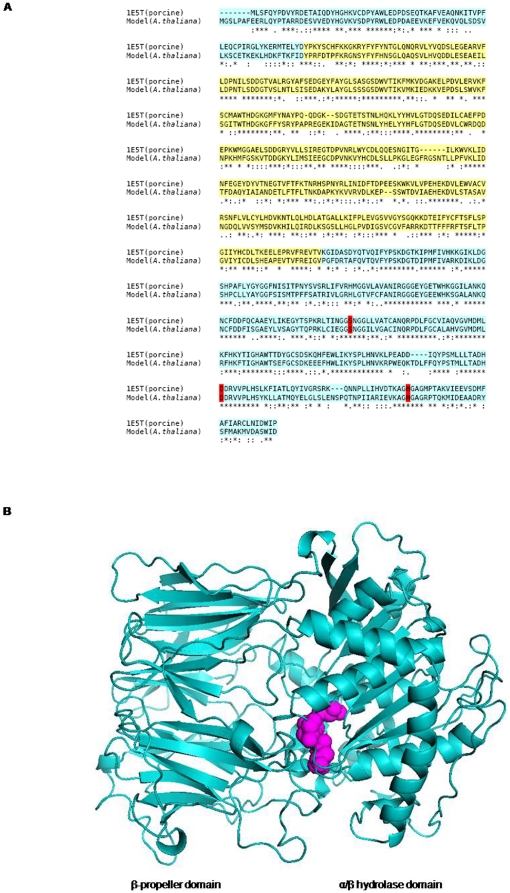
Model generation.
a) alignment between query (At1g20380) and template (PDB ID: 1E5T, porcine) generated by CLUSTALW, sequence identity was found to be 53%. α/β hydrolase domain is cyan colored and β-propeller is shown in yellow color. Active site residue conservation is shown in red color b) homology model of A. thaliana POP generated using porcine POP as a template. Catalytic triad is shown in magenta color.